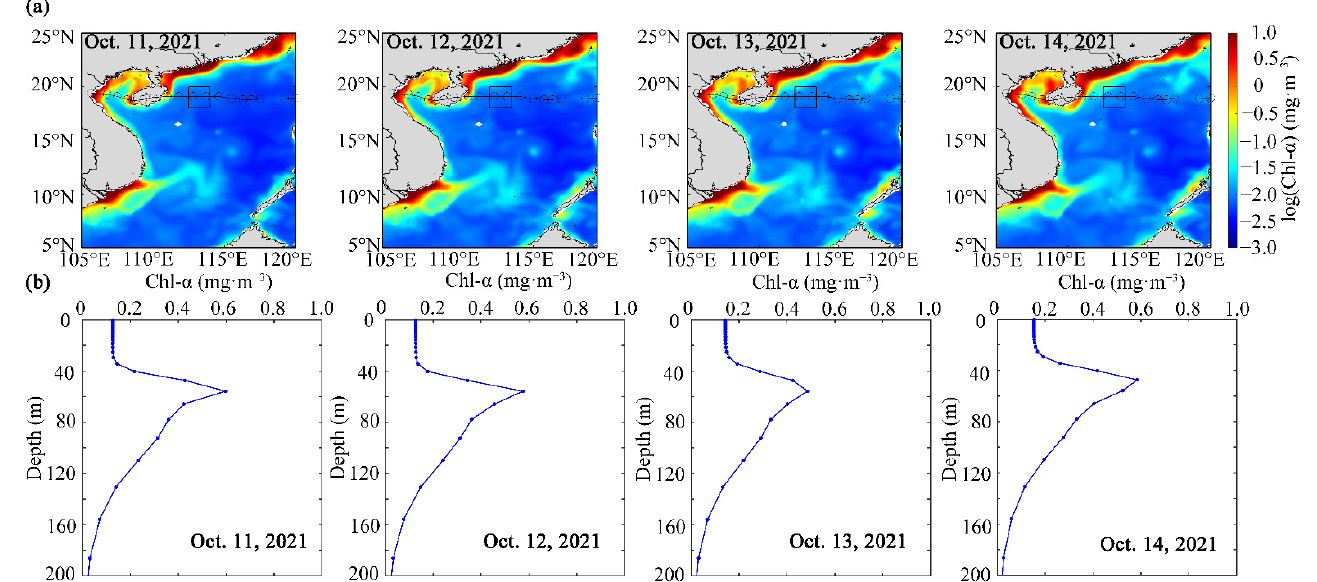
Figure 5. Chl- a changes before and after the passage of TY “Kompasu”. ( a ) Horizontal distribution of surface Chl- a . ( b ) Vertical profiles of the regional average of Chl- a in the black box of the study area. Before the passing of TY (11–12 October 2021), after the passing of TY (13–14 October 2021). The black hollow circle represented the location of the TY every 6 h, and the black line represented the path of the TY.